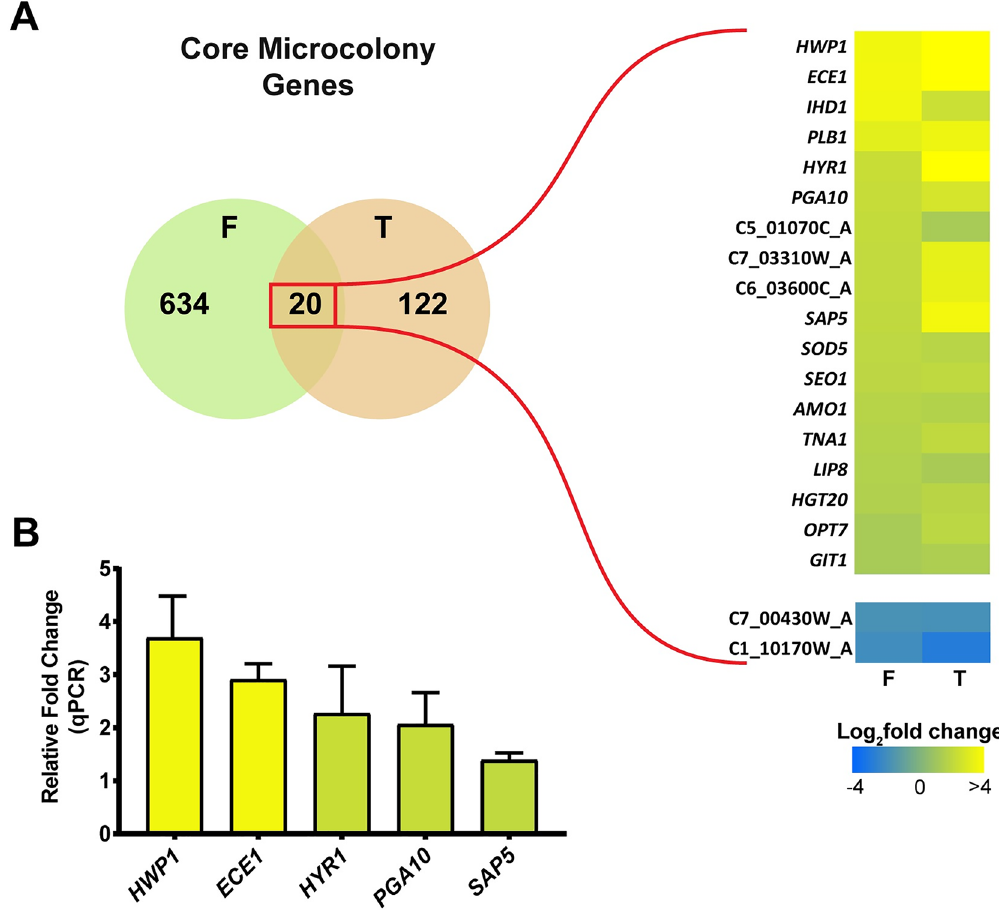
Fig 3. Twenty common genes are differentially regulated in microcolonies formed by both flow and temperature. ( A ) RNA-seq was performed on CAI4 biofilms grown under microcolony inducing conditions (37˚C with flow) and compared to non-microcolony biofilms grown at 37˚C without flow ( F ) or at 23˚C with flow ( T ). Numbers in the Venn diagram indicate differentially regulated genes from each dataset with the genes in the overlap region also sharing the direction of regulation (increased or decreased in both datasets). A heatmap of the expression data of the 20 core microcolony genes is shown on the right. ( B ) Expression of the core microcolony genes HWP1 , ECE1 , HYR1 , PGA10 and SAP5 was quantified by qRT-PCR on CAI4 microcolonies grown under flow and 37˚C, and compared to CAI4 non-microcolony biofilms grown at 37˚C without flow. Expression data was first normalized to control actin prior to comparison between samples. The results represent the averages from triplicate samples from two independent experiments. The error bars indicate standard